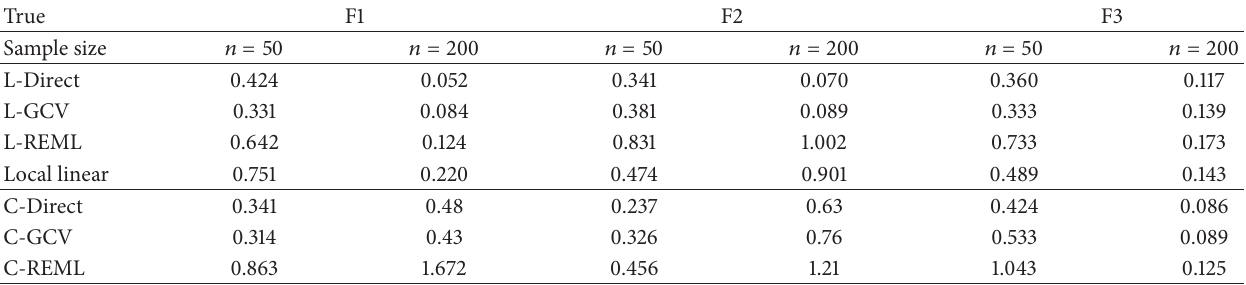
Table 3: Results of sample PSE for 𝑛 = 50 and 𝑛 = 200 . All entries for PSE are 10 2 times their actual values. True F1 F2 F3 Sample size 𝑛 = 50 𝑛 = 200 𝑛 = 50 𝑛 = 200 𝑛 = 50 𝑛 = 200 L-Direct 0.424 0.052 0.341 L-GCV